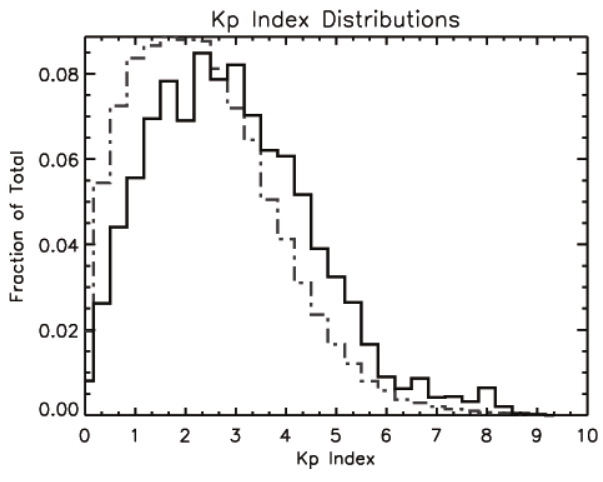
Fig. 1. Distribution of Kp index values corresponding to NGDC database anomaly epochs (solid line) and the distribution of all Kp values over the temporal span of the database (1963 to 1994). Al- though there is a clear shift between the two distributions, only 15% of all anomalies in the database occured during disturbed or stormier (greater than 5 − Kp) conditions.